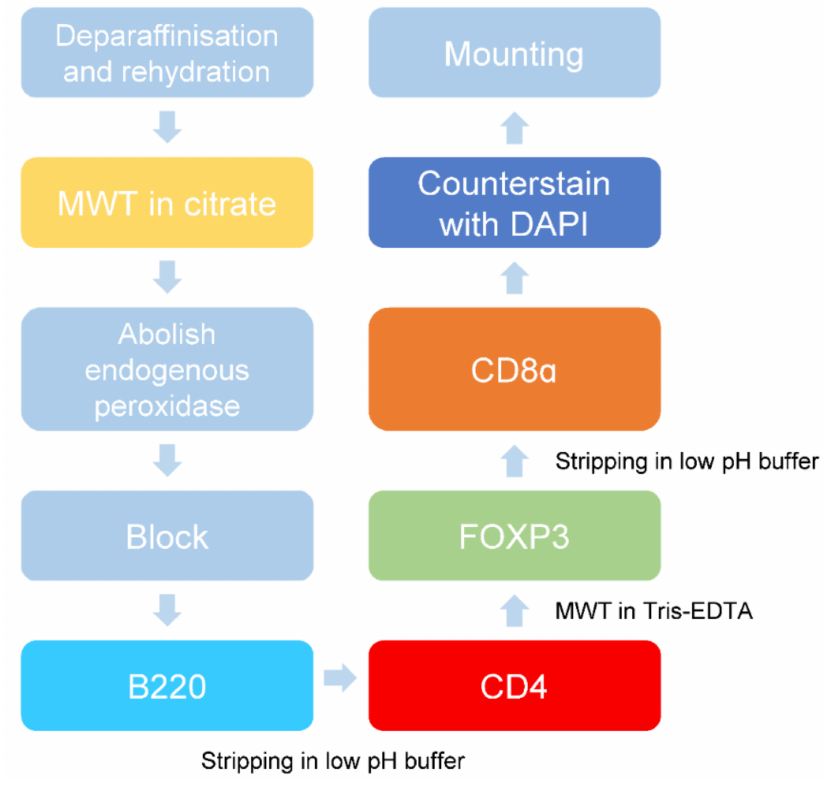
Figure 3. Schematic of the optimised multiplex staining